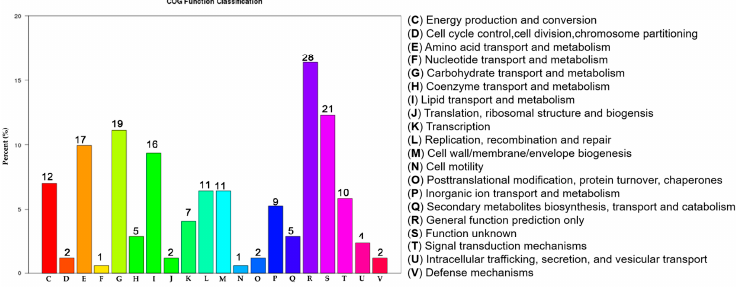
Figure 4. HemK regulates multiple clusters of orthologous genes (COG) functional categories. The x -axis represents the functional classification of each COG category. The y -axis represents the relative abundance (%) of DEGs in each COG category. The number of genes (presented above each category) in different functional classes reflects the metabolic and physiological bias in a certain period or environment.